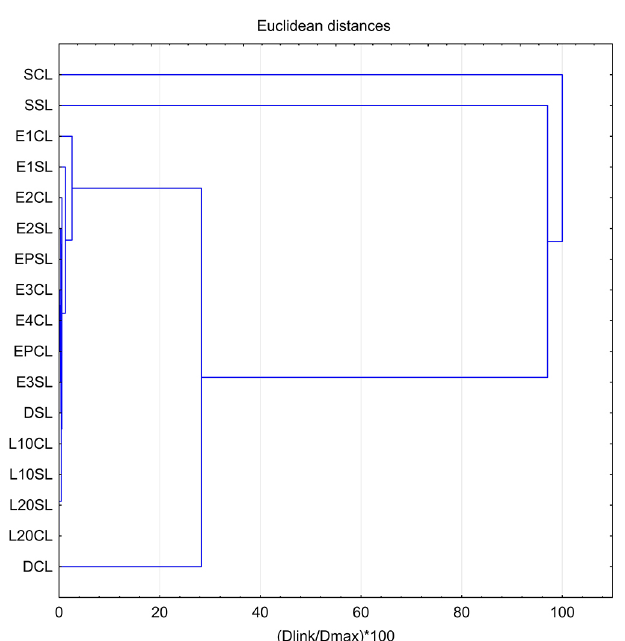
FIGURE 3 - Cluster Analysis about differentiation of dermis with laser and Swab with and without laser when compared to the other experimental data. Notes: SCL = Swab with laser; SSL=